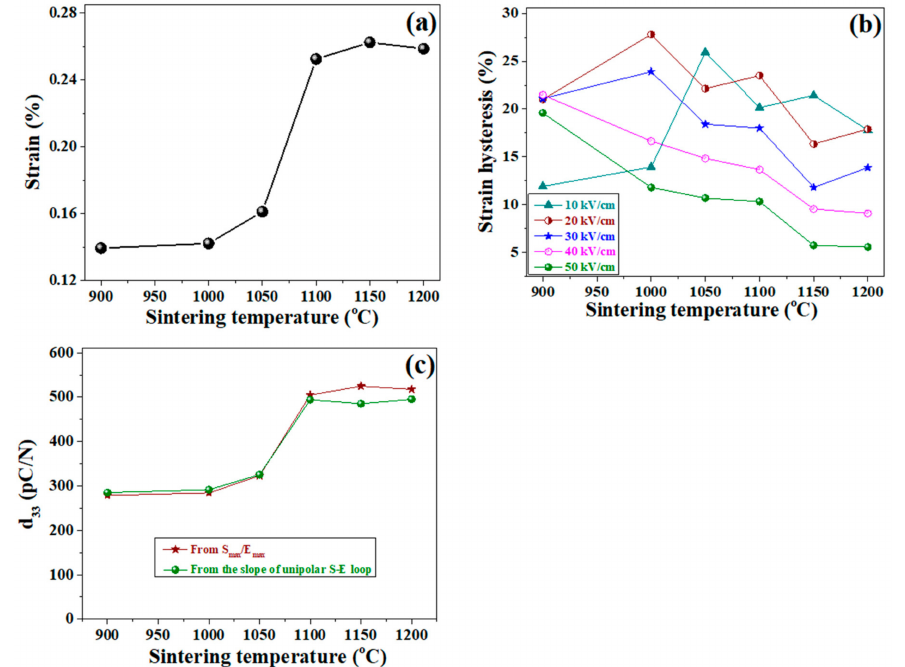
Figure 7. ( a ) Maximum strain and ( b ) strain hysteresis vs. sintering temperature curve for microwave-sintered PLZT 8 / 60 / 40 ceramics measured at 50 kV / cm. ( c ) Change in d 33 calculated from the slope of the S-E curve and by dividing maximum displacement and maximum field vs. temperature curve at 50 kV /